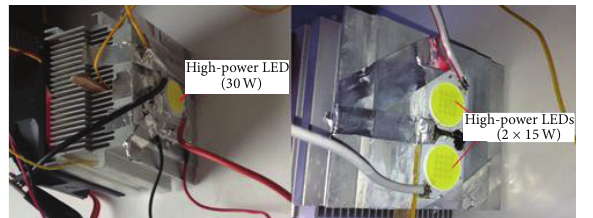
Figure 3: Cooling system with thermoelectric cooler (TEC) and heat pipe cooling